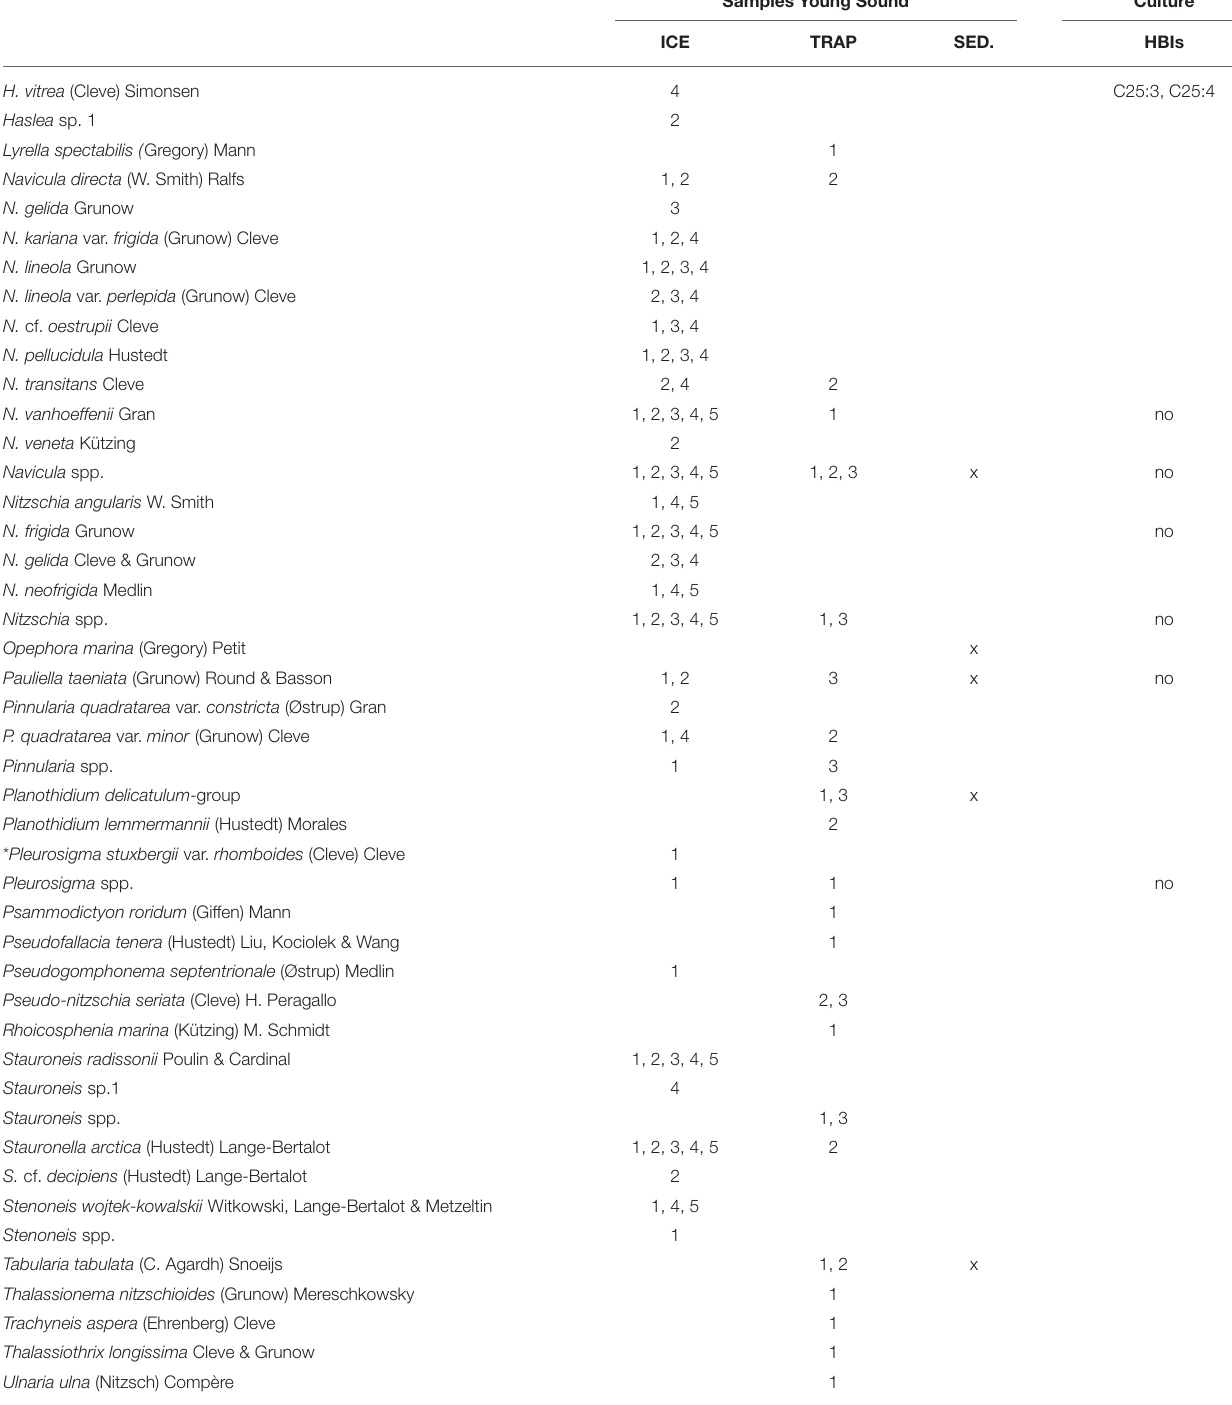
Tabularia tabulata (C. Agardh)